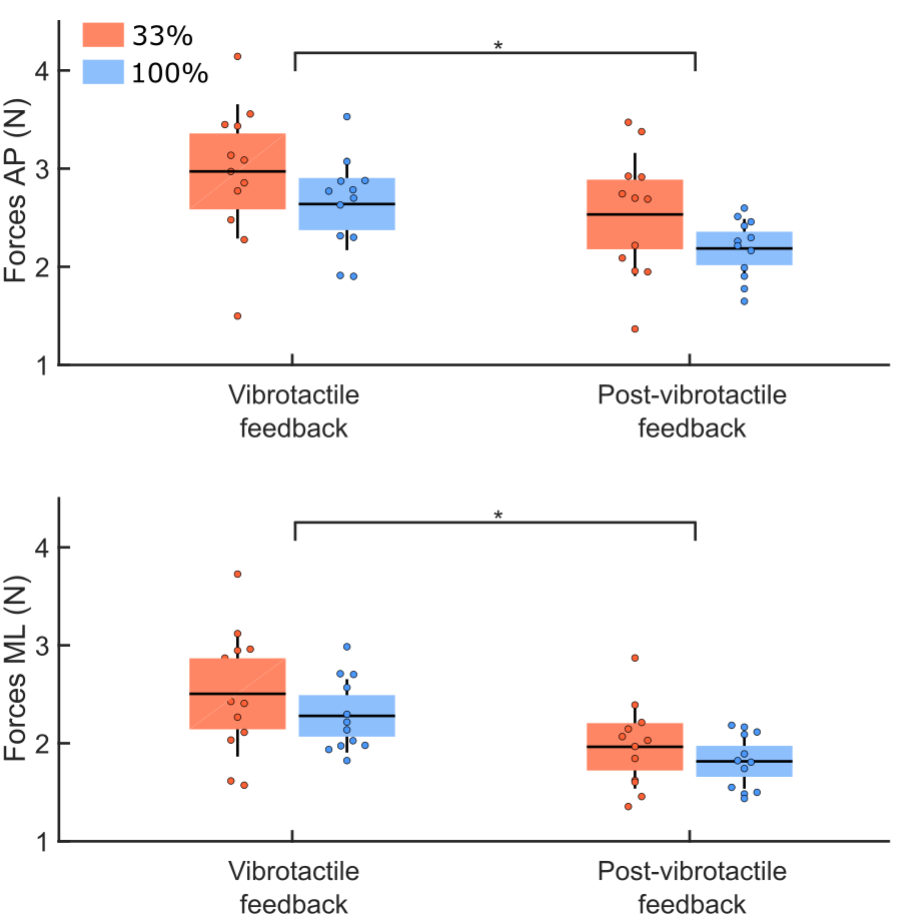
Figure 10. RMS values of the ground reaction forces along the AP (upper panel) and ML (lower panel) axes for both groups (33% and 100% feedback groups, red and blue boxes, respectively). These data are for the vibrotactile (last 10 trials mean) and the post-vibrotactile conditions. The dots represent the mean results for each participant, horizontal lines depict the group’s means, boxes represent the group’s standard error of the mean, and vertical lines, one standard deviation. The asterisks (*) indicate a significant main effect of condition.